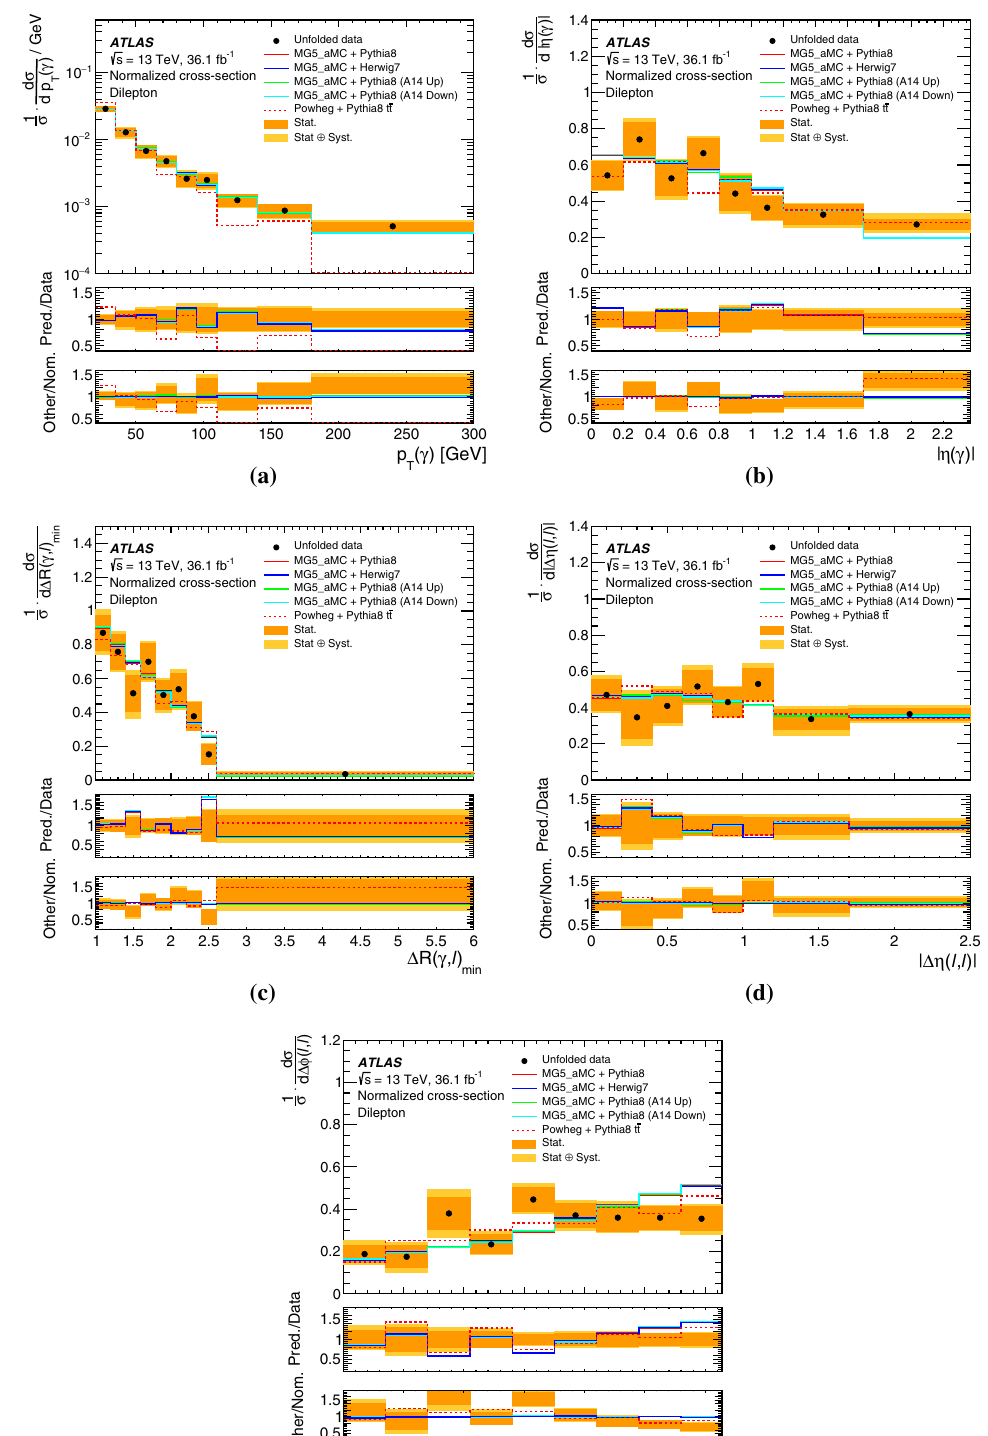
MG5_aMC +Herwig 7, and the Powheg + Pythia 8 t ¯ t where photon radiation is modelled in the parton shower. The top ratio-panel shows the ratios of all the predictions over data. The bottom ratio-panel shows the ratios of the alternative predictions and data over the nominal pre- diction. Overflows are included in the last